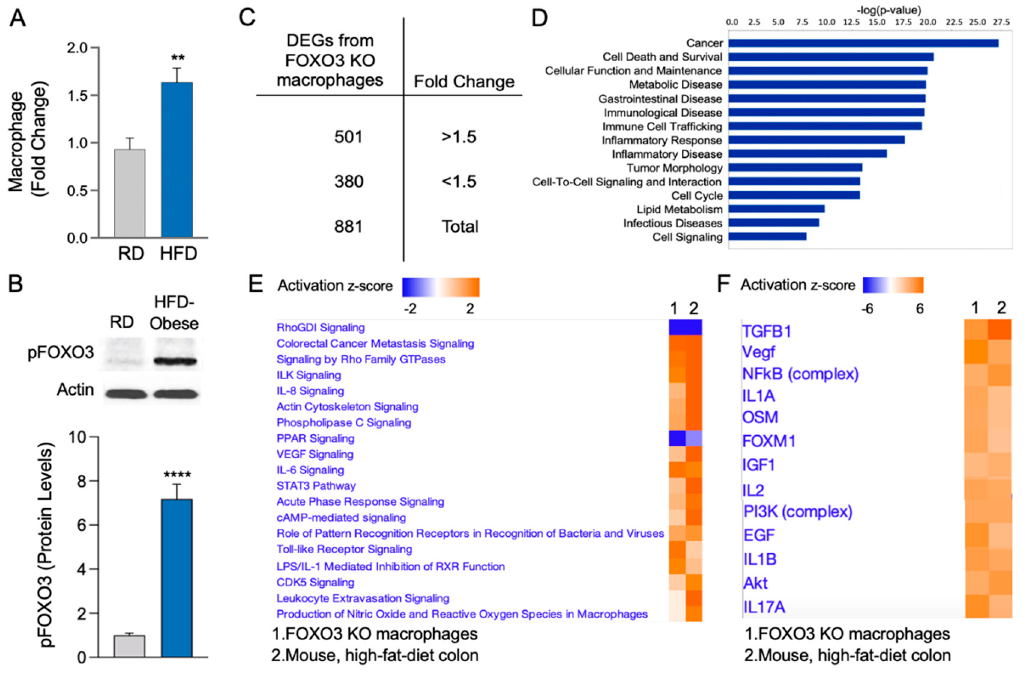
Figure 1. High-fat-diet obesity in mice results in an increased presence of colonic macrophages along with loss of FOXO3. ( A ) Transcriptomes from colon of high-fat-diet (HFD) obese mice showed augmented macrophage presence relative to control mice (regular diet, RD) colon (CIBERSORT, n = 3 per group, ** p < 0.01). ( B ) Colons of mice fed with HFD showed increased phosphorylation of FOXO3 compared to colons of control mice (RD). Actin was used as a loading control. Graph represents pFOXO3 densitometric quantification ( n = 3 per group, **** p < 0.0001). ( C ) Differentially expressed genes (DEGs) from FOXO3-deficient macrophages relative to control ( n = 3 for each group, FC > |1.5|, FDR < 0.05). ( D ) Top diseases and pathways affected by FOXO3-deficient macrophages relative to control ( p < 0.05, IPA). ( E , F ) Top canonical pathways and upstream regulators affected by FOXO3-deficient macrophages, which are altered in HFD obese mouse colon (SRP093363) ( n = 3 per group, p < 0.05,